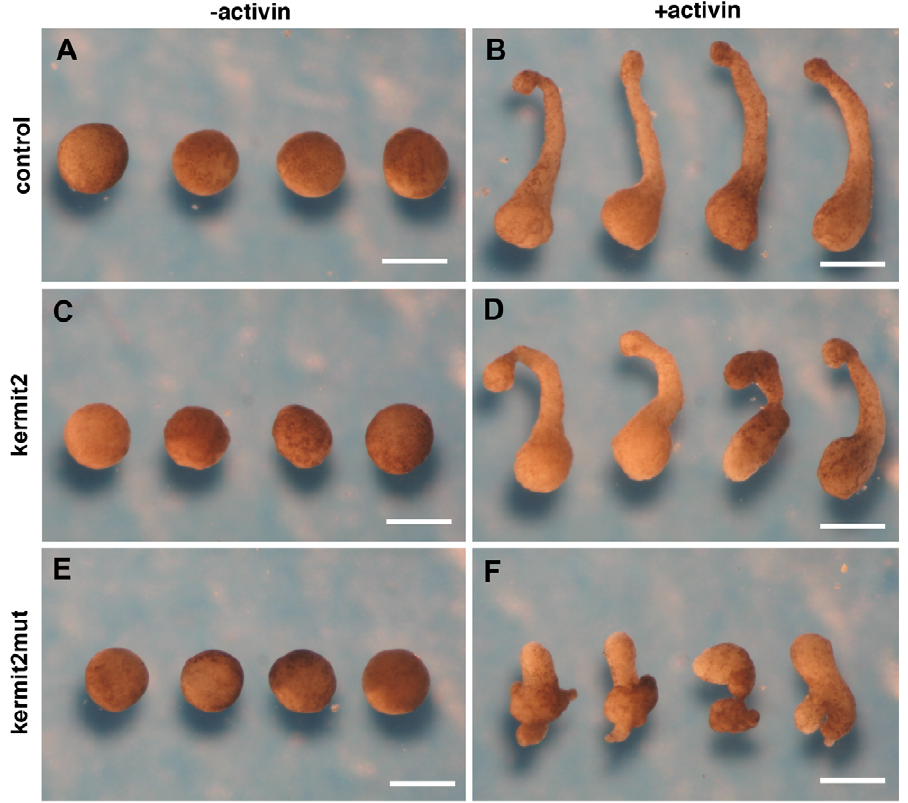
Figure 3. Animal cap assays (A, C, E) minus activin or (B, D, F) plus activin. (A, B) Control activin-treated animal caps extend. (C, D) Kermit2 has no effect on activin-treated animal cap extension. (E, F) Kermit2mut inhibits activin-treated animal cap elongation. Size marker =100 m M.